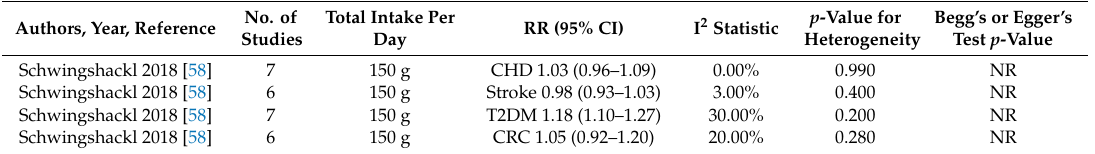
Table 13. Summary of linear dose-response meta-analyses on potato intake and CHD, stroke, T2DM, CRC.